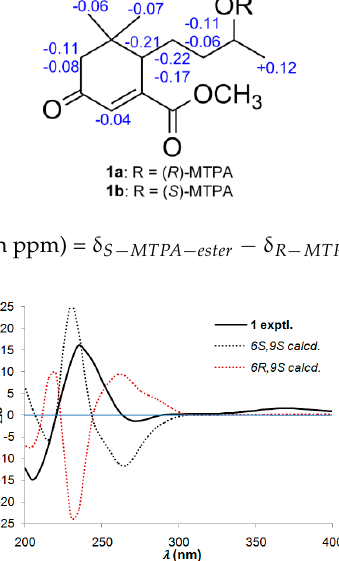
Figure 4. Experimental and calculated ECD spectra of 1 .